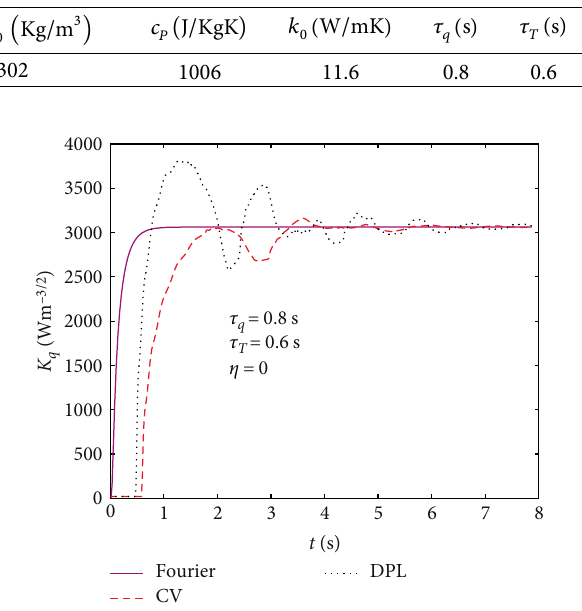
Figure 3: Effect of heat conduction model on HFIF for a homogeneous